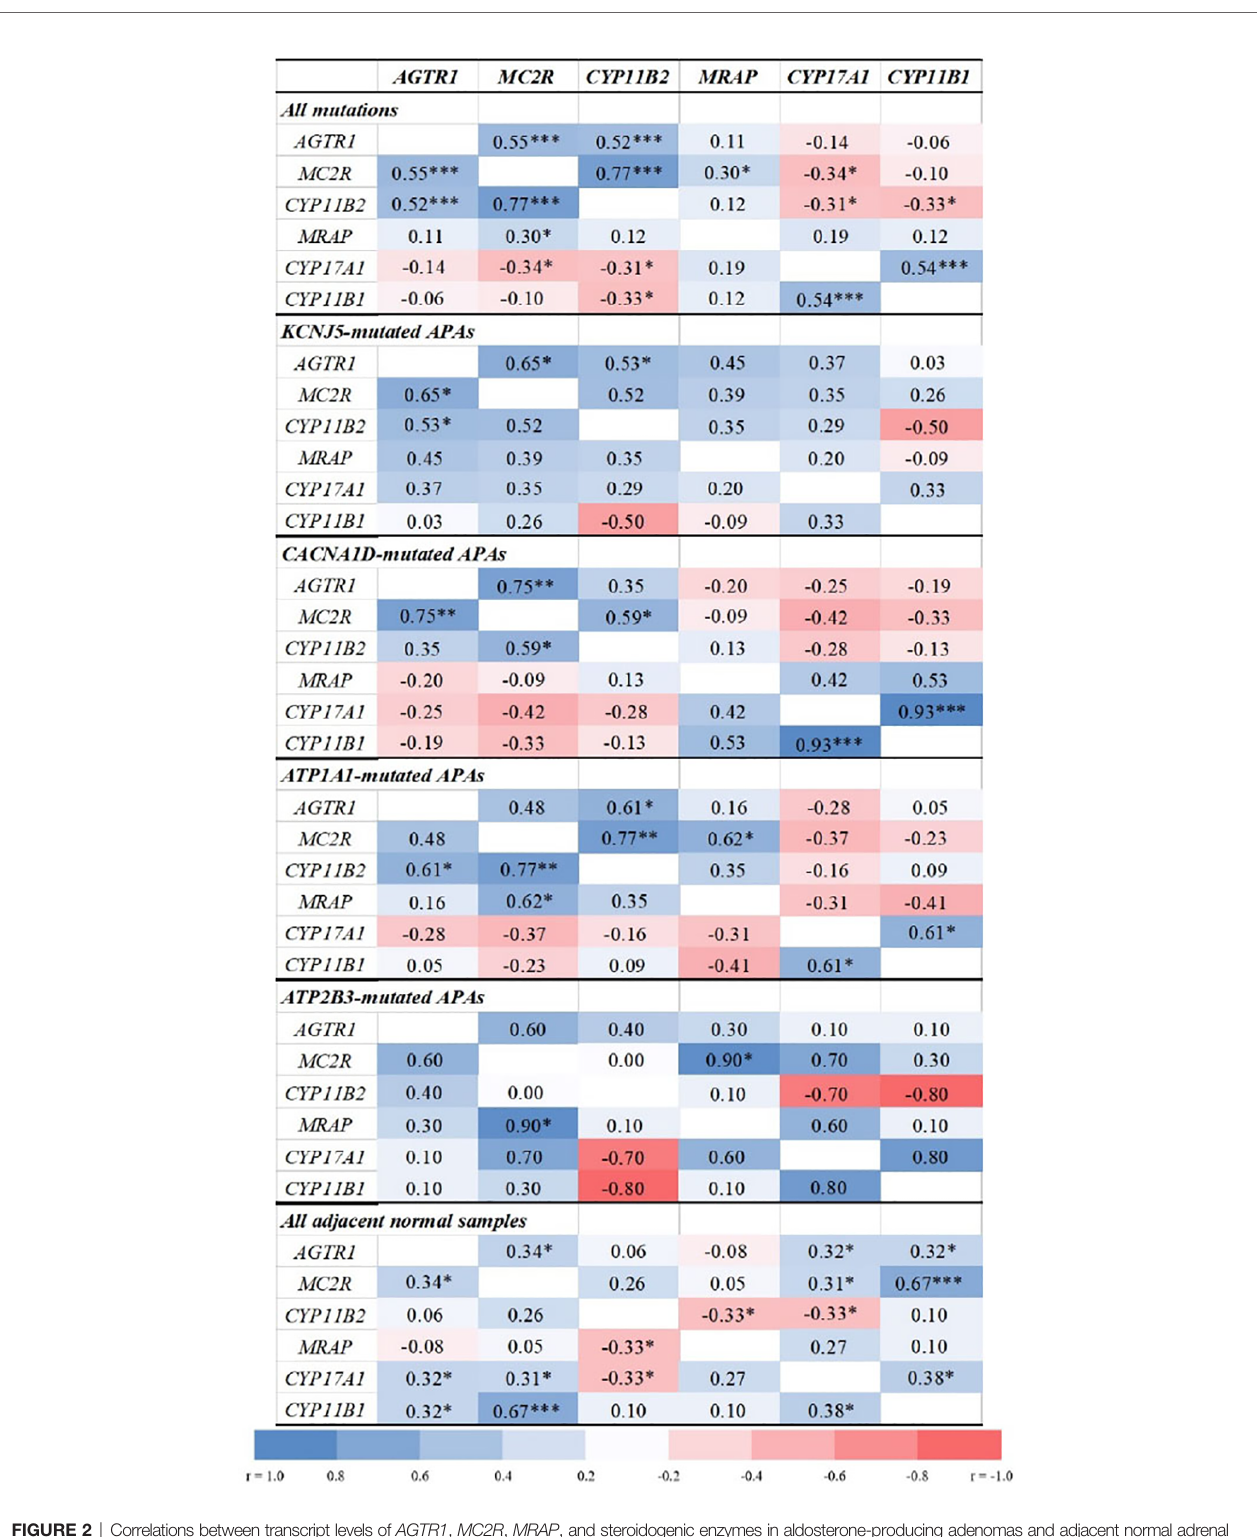
FIGURE 2 | Correlations between transcript levels of AGTR1 , MC2R , MRAP , and steroidogenic enzymes in aldosterone-producing adenomas and adjacent normal adrenal tissue. AGTR1 , type 1 angiotensin II receptor; MC2R , melanocortin type 2 receptors (ACTH receptors); CYP11B2 , aldosterone synthase; MRAP , melanocortin 2 receptor accessory protein; CYP17A1 , 17 a -hydroxylase; CYP11B1 , 11 b -hydroxylase. Correlation analyses were done using the Spearman correlation test. * p < 0.05, ** p < 0.01, *** p <